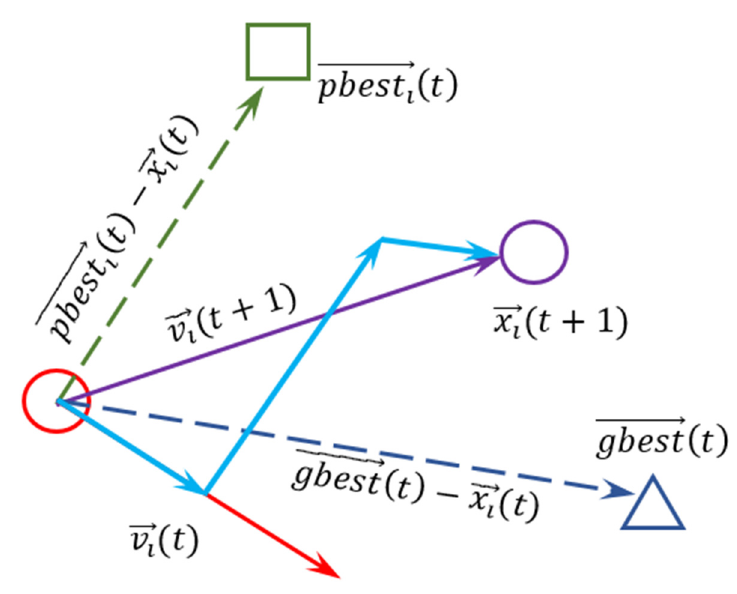
Figure 6. Behavior of the individual in Particle Swarm Optimization.